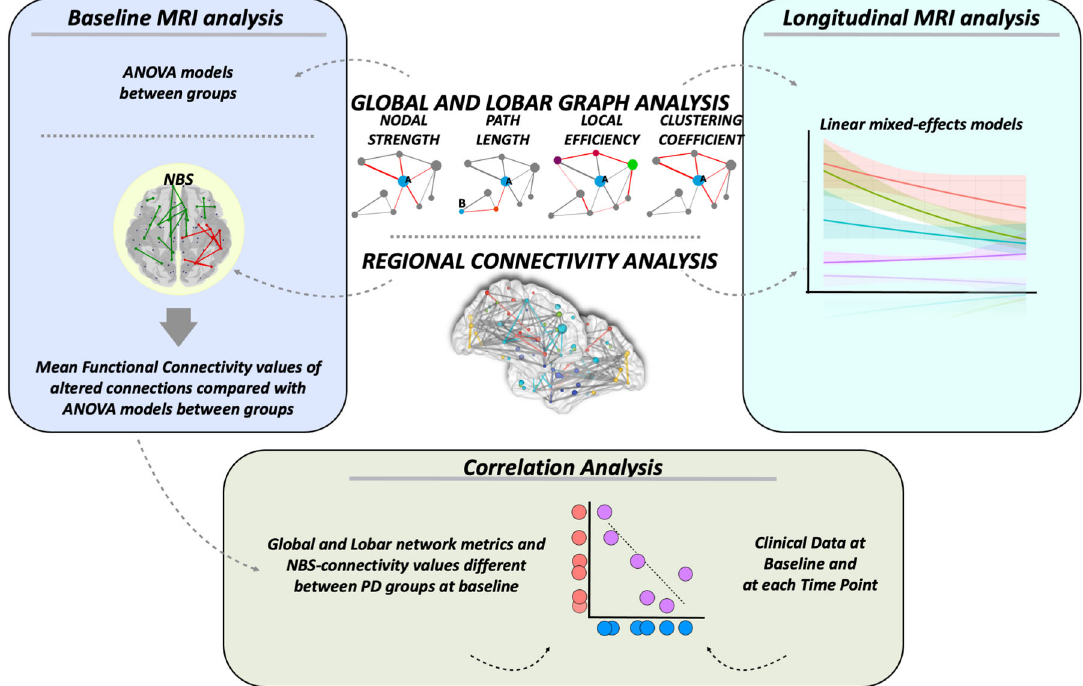
Fig. 5 MRI processing pipeline. Baseline MRI analysis. Global and lobar network topological metrics were compared between groups using ANOVA models. NBS analysis compared functional connectivity between groups. Mean functional connectivity values of the resulting altered connections were obtained and compared between groups using ANOVA models. Longitudinal MRI analysis. Linear mixed-effects models were implemented to investigate global and lobar network measures and functional connectivity changes over time. Correlation analysis. Partial correlations were assessed between baseline fMRI metrics (global and lobar network metrics and NBS-connectivity values, which were found to be different between PD groups) and clinical data at baseline and at each time point using Pearson ’ s correlation coef fi cient. NBS network-based